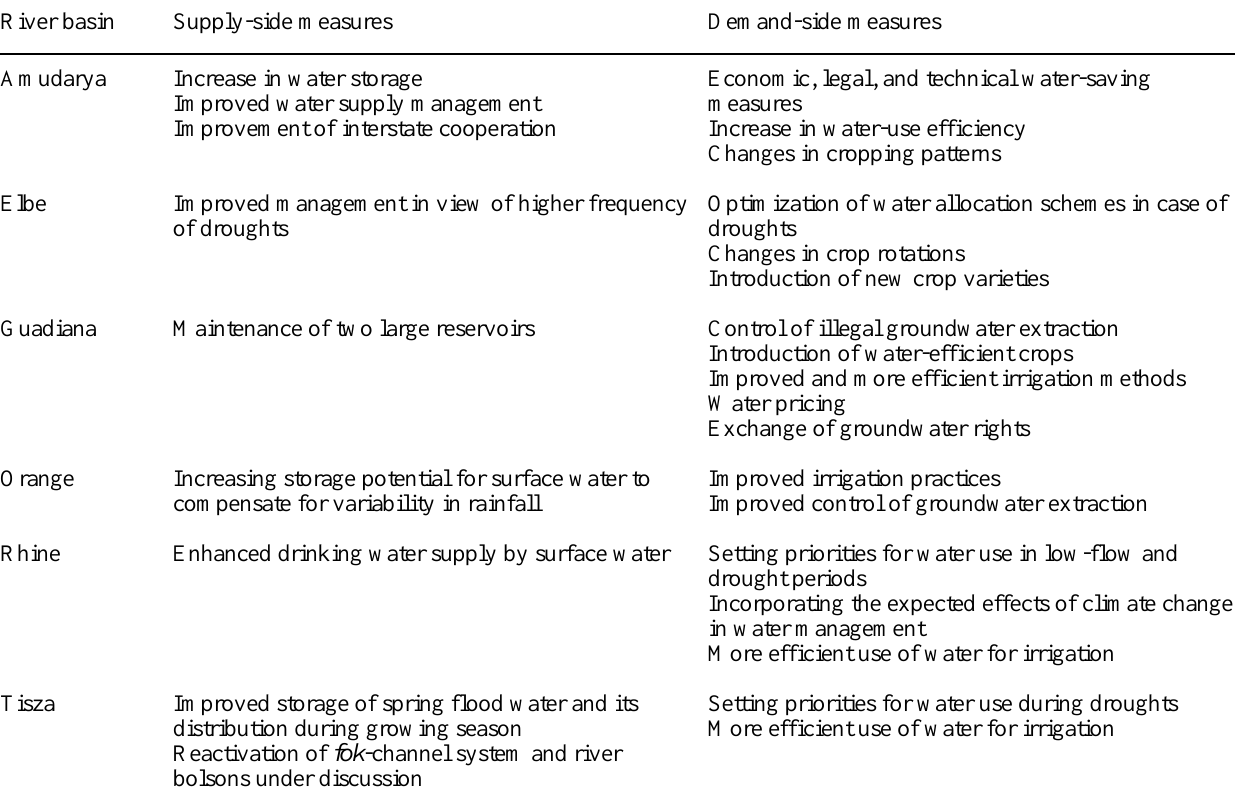
Table 7B. Improvement of measures for coping with droughts needed. River basin Supply-side measures Demand-side measures Amudarya Increase in water storage Improved water supply management Improvement of interstate cooperation Elbe Improved management in view of higher frequency of droughts Guadiana Maintenance of two large reservoirs